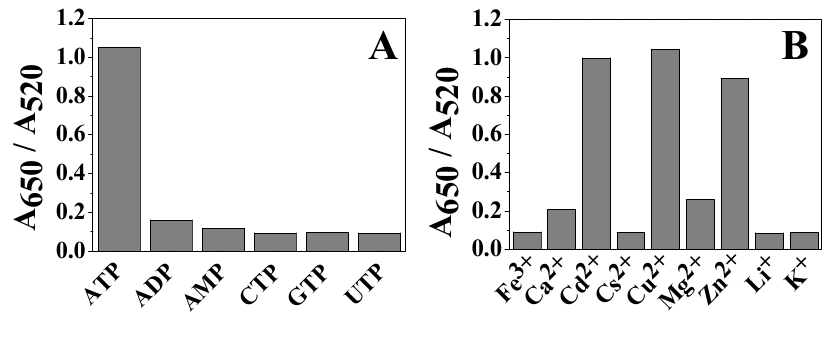
/A ratio of AuNPs in different systems: ( A ) ATP/interferences + Cu 2+ Figure 5. The A 650 520 and ( B ) ATP + different metal ions. The concentrations of ATP, ATP analogs and metal ions are 15, 15 and 30 μ M,